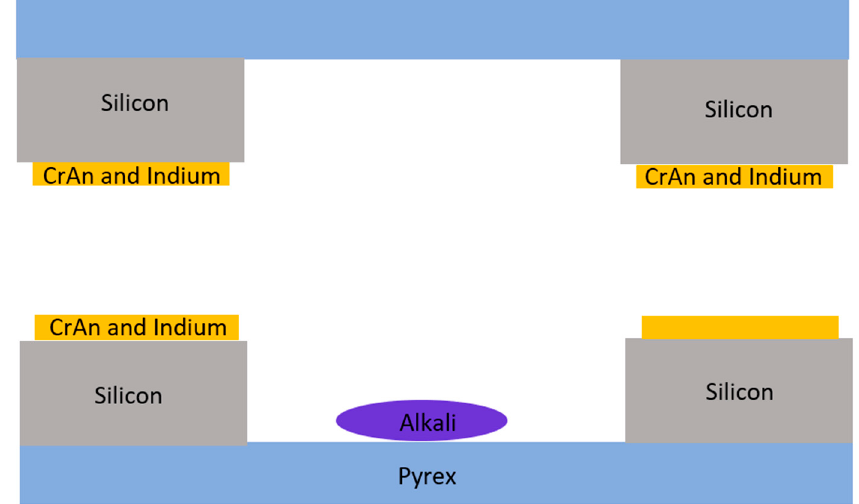
Figure 3. Thin-film-bonded alkali metal vapor cells.